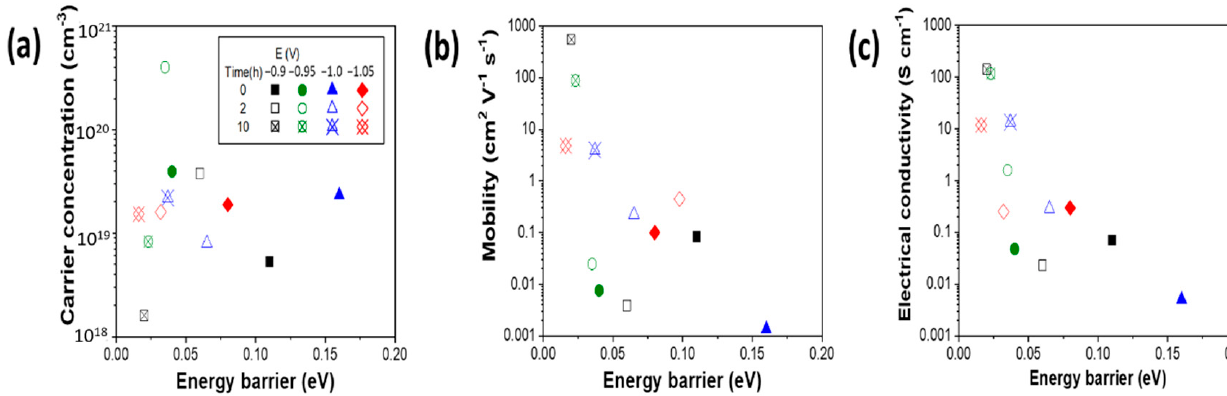
Figure 5. Carrier concentration ( a ), mobility ( b ) and electrical conductivity ( c ) as a function of energy barrier (EB) of as-deposited and annealed PbTe films at 200 °C for 2 and 10 h.